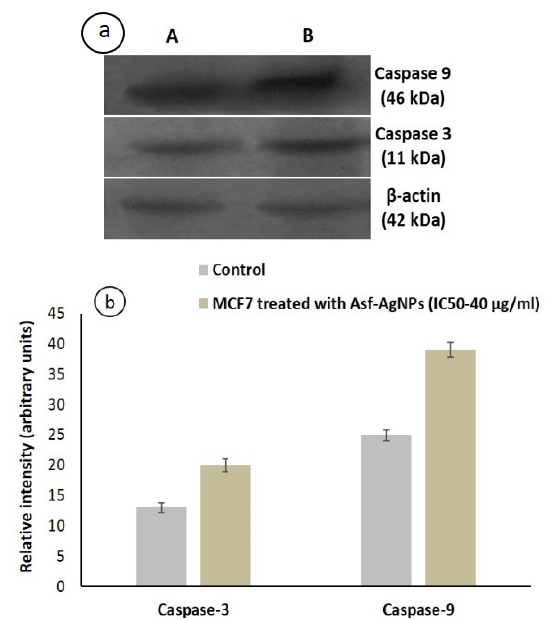
Figure 12. ( a ) Effects of Asf-AgNPs on expression levels of caspases 3 and 9 apoptotic proteins by western blot analysis. (A) Control, (B) Asf-AgNPs (IC 50 concentration at 40 µ g / mL with 48 h). ( b ) Quantitative data representing the corresponding protein levels assessed using densitometry. Y axis represents relative intensity (arbitrary units). Each column represents the mean ± SD of three independently performed experiments. The statistical significance in the expression of apoptotic protein was observed in the treatments (MCF7 treated with Asf-AgNPs (IC 50 at 40 µ g / mL) when compared with the control at p value < 0.05.